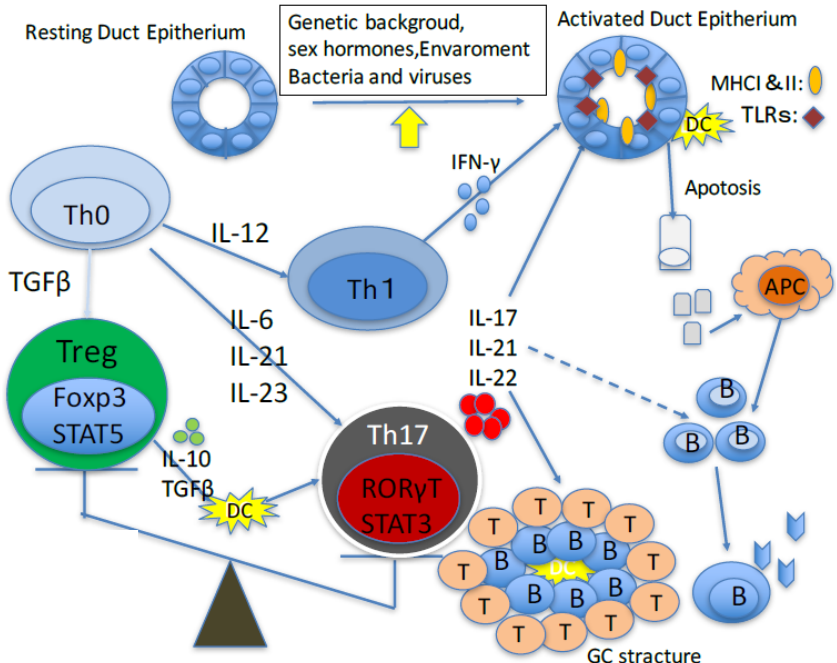
Figure 1. Cells and molecules that derive the pathogenesis of primary Sjögren’s syndrome. APC: